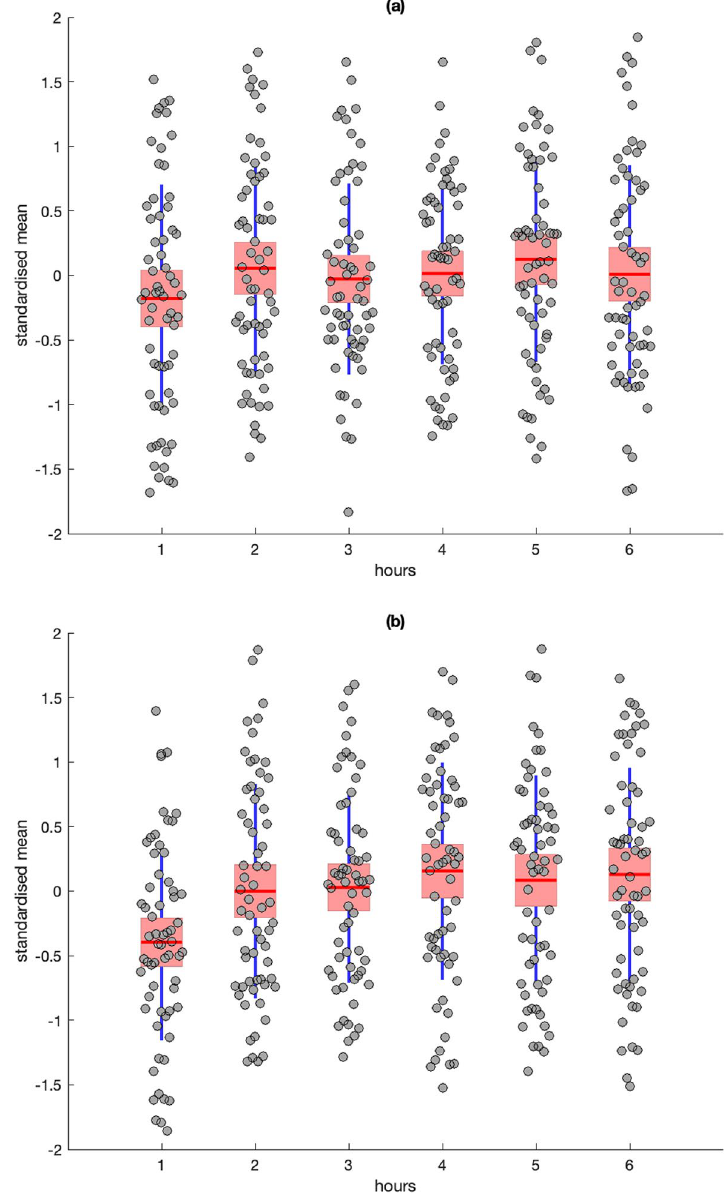
Figure 3. Descriptive statistics for standardised residuals from Skin Conductance Level (SCL) ( a ) and frequency of Skin Conductance Response (SCR) ( b ). Red line = mean, pink box = standard deviation, blue lines = 95% confidence intervals, grey circles = raw data.